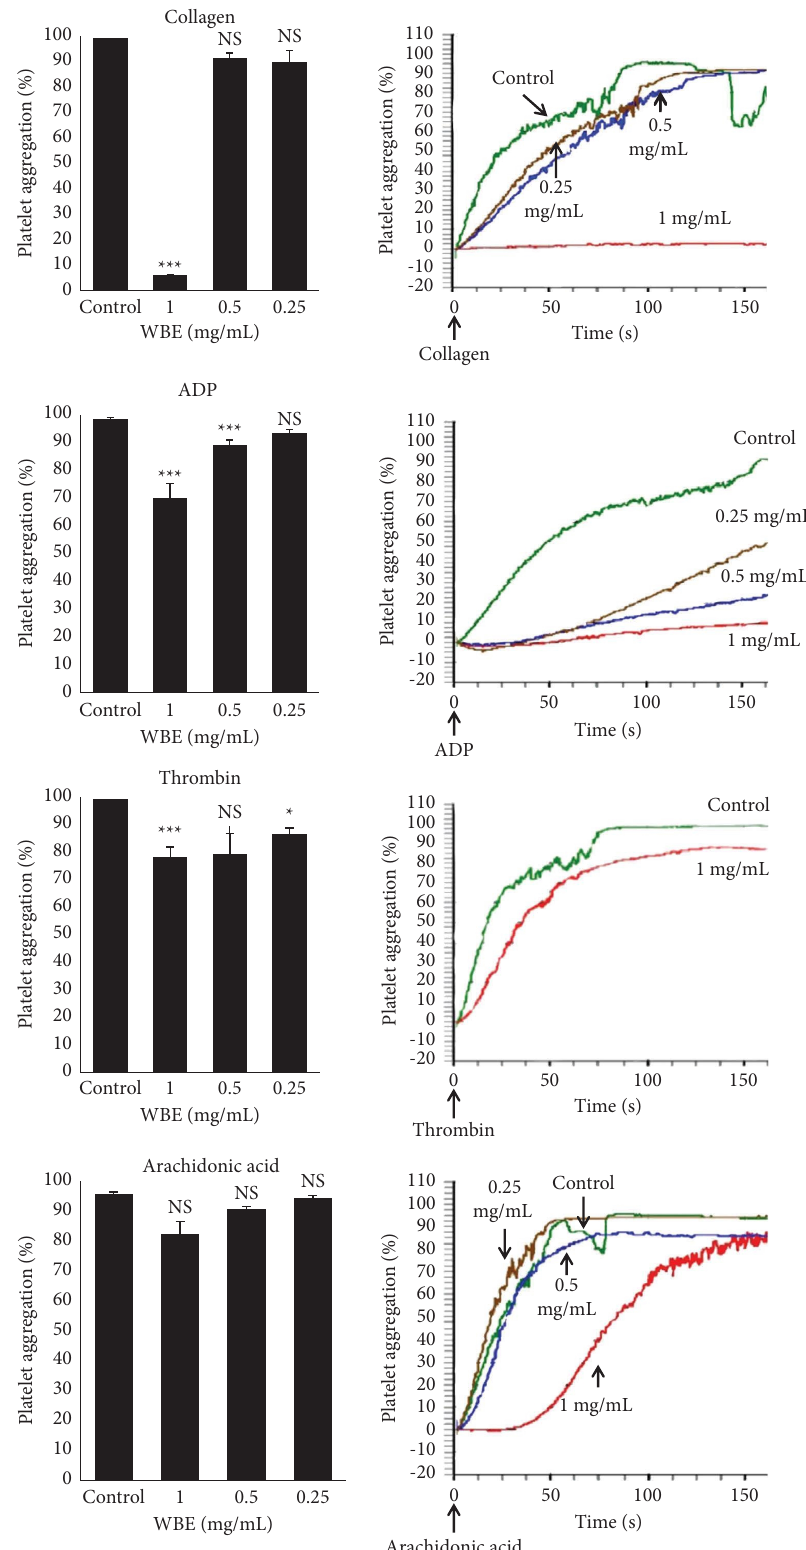
Figure 2: In vitro platelet aggregation traces and histograms showing the efect of 0.25, 0.5, and 1mg/mL of walnut bark extract (WBE) on collagen (5 μ g/mL), ADP (5 μ M), thrombin (0.5U/mL), and arachidonic acid (20 μ M) induced platelet aggregation. ∗ p < 0 . 05, ∗∗∗ p < 0 . 001, ns: nonsignifcant when compared to control samples (washed platelets incubated without extract) n � 3 −